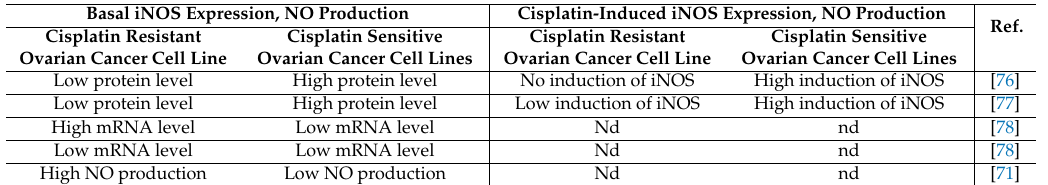
Table 2. Correlation of iNOS expression and / or NO production with resistance of ovarian cancer cell lines to